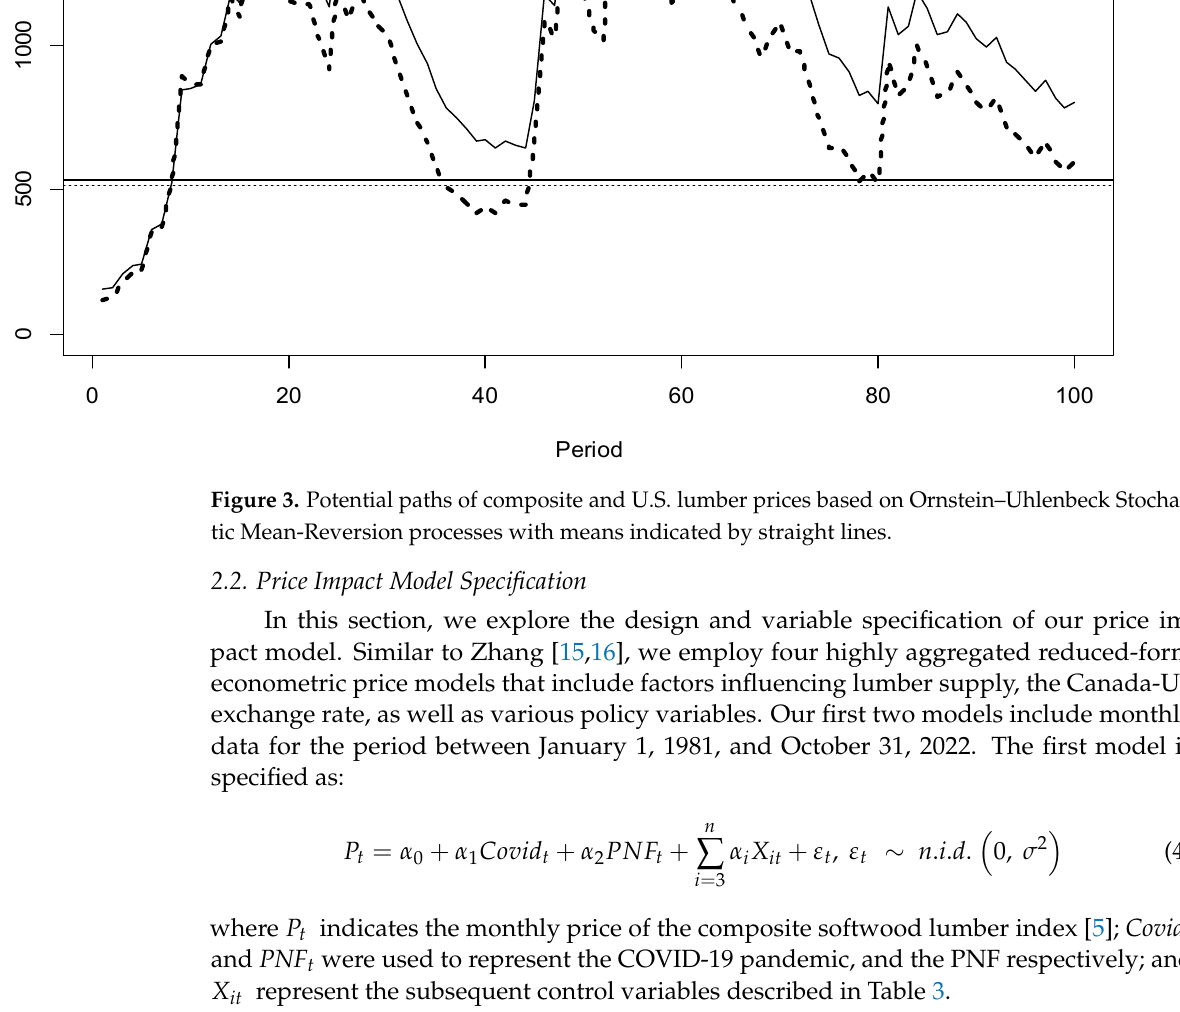
Table 2. Parameter Estimates for Stochastic Process Model a .